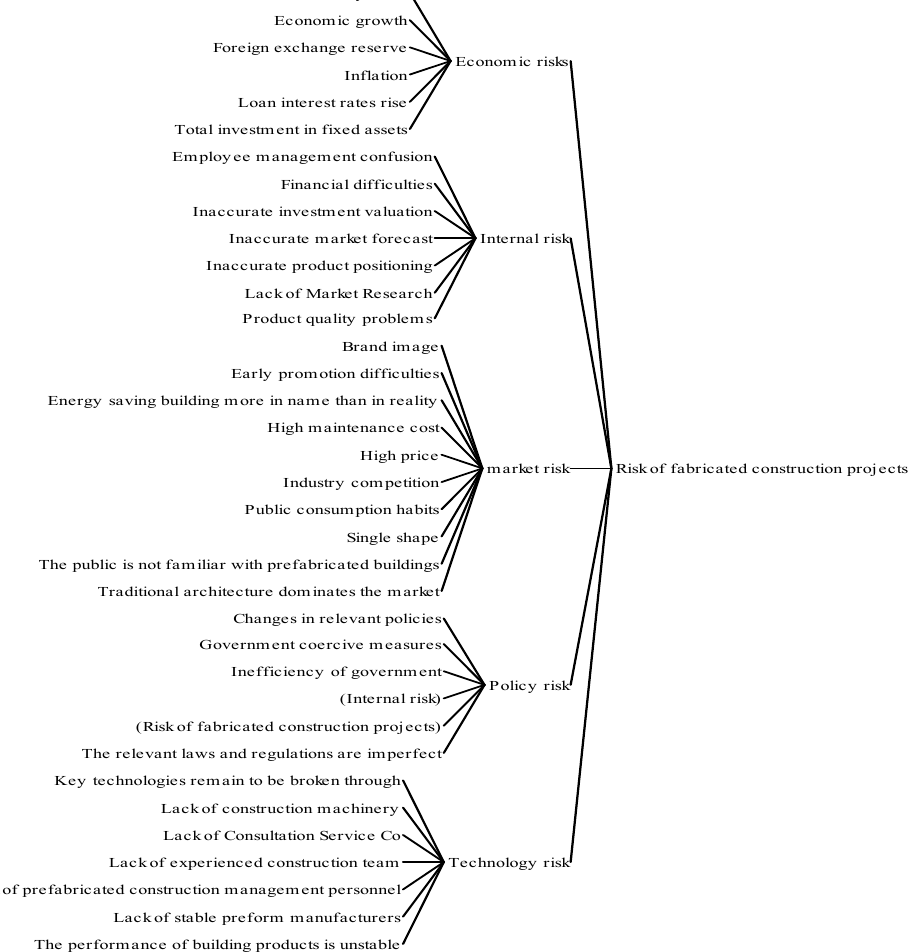
Figure 4. Analysis of risk tree of a prefabricated construction project.